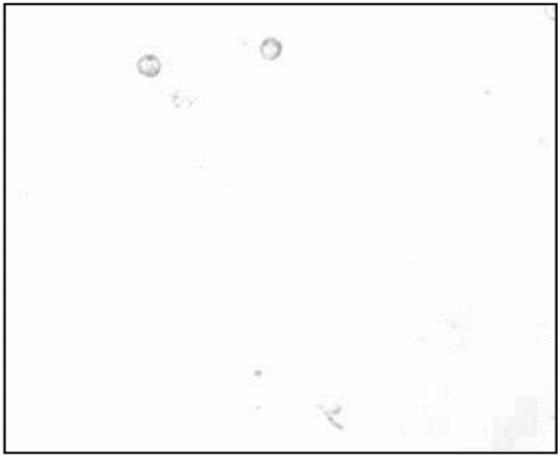
Figure 6. Grey-scale image after contrast